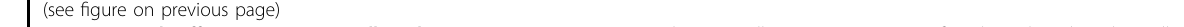
Fig. 3 Pimozide affects cancer stem cell marker expression. a KHOS/NP and SJSA-1 cells were grown in speci fi c spheroid media in low adherent plates and treated with 0 – 25 μ M of pimozide. After 5 days, the spheroids were photographed and counted. Scale bars represent 100 μ m. b Primary spheroids were collected and separated into single cells and re-plated. Pimozide treatment signi fi cantly inhibited osteosphere formation (* p < 0.05). c and d Western blot analyses of lysates from 3D cultures showed signi fi cant increase of DCLK1 short form in both KHOS/NP and SJSA-1 cells when compared to 2D cultures. Pimozide inhibits the expression of the DCLK1 isoforms. Western blot analyses of lysates from 3D cultures showed signi fi cant increase of CD44, CD133, Oct-4, and ABCG2 levels in both KHOS/NP and SJSA-1 cells when compared to 2D cultures which was suppressed by pimozide. e Sorting of anti-DCLK1 antibody-tagged phycoerythrin in KHOS/NP and SJAS-1 cells by fl ow cytometry. After 24 h, pimozide treatment resulted in a signi fi cant reduction in the number of DCLK1 positive